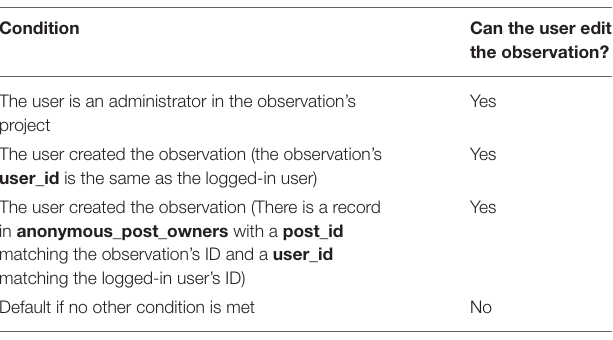
TABLE 3 | Anonymity conditions and user access.